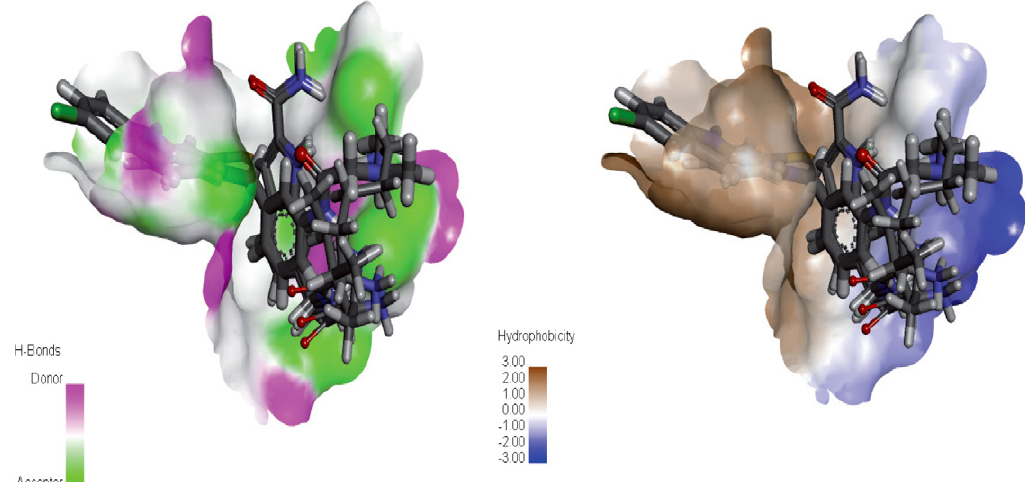
Fig. 6. The orientation of HIV 1 PR inhibitors in the active site and hydrogen and hydrophobic surface